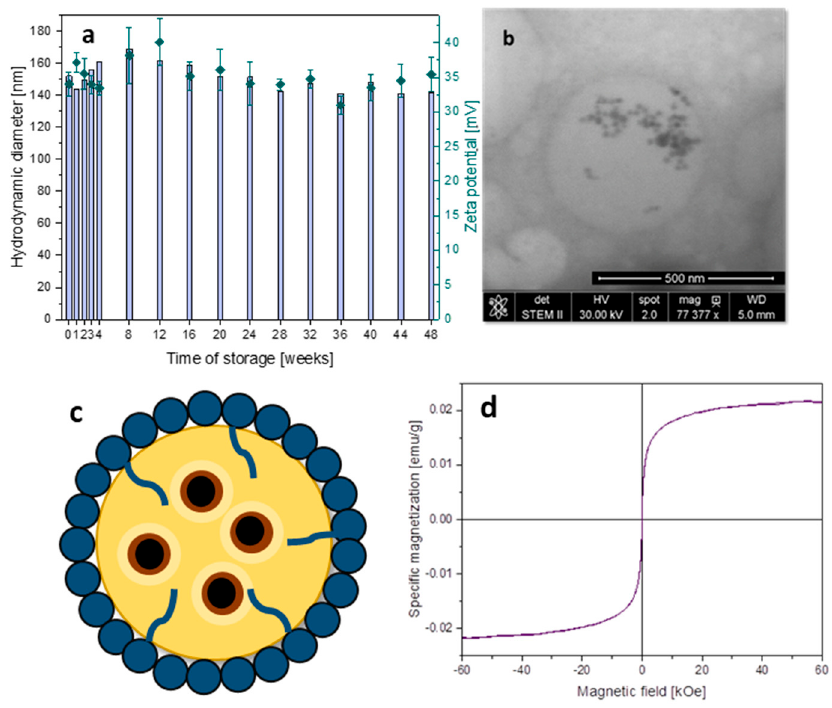
Figure 6. ( a ) Hydrodynamic diameter (columns, left scale) and potential zeta (points, right scale) of capsules with encapsulated MNPs over 48 weeks of storage; ( b ) STEM image of the capsule template on n -octadecane core with encapsulated MNPs; ( c ) scheme of the capsule with chitosan-based shells and magnetic nanoparticles embedded in the oil interior; ( d ) magnetization vs. magnetic field at 300 K of the aqueous dispersion of the capsules with encapsulated MNPs.